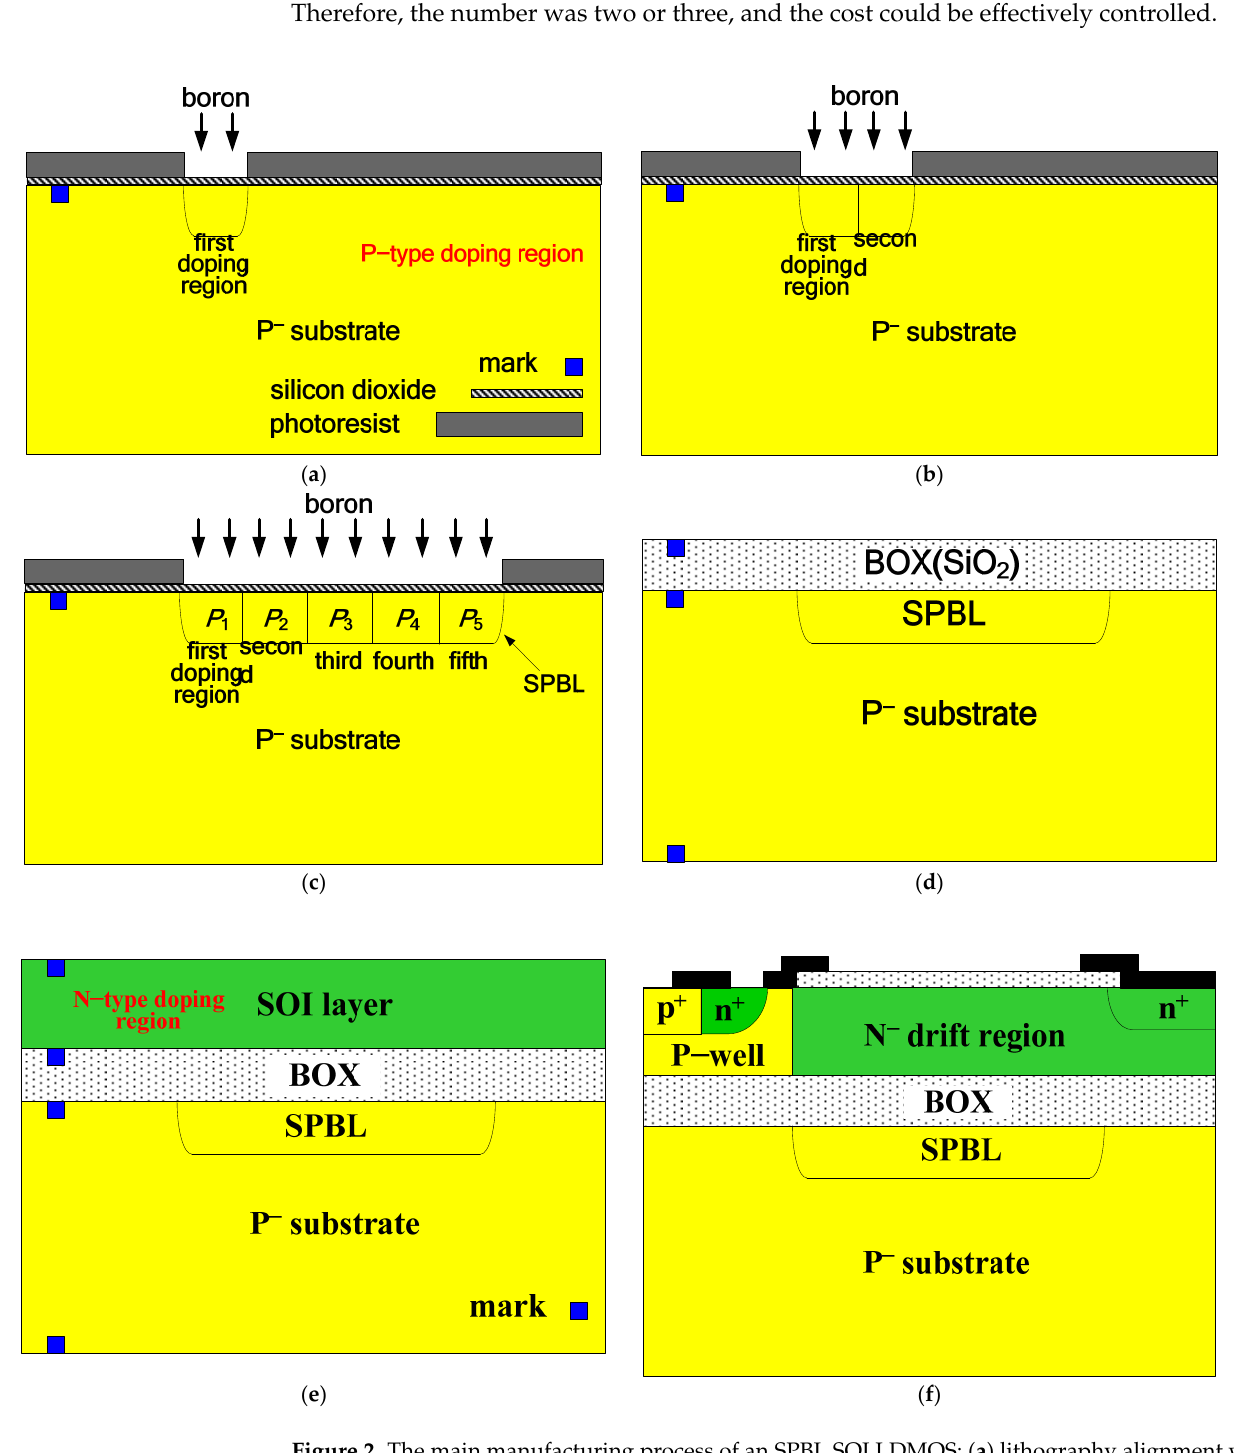
Figure 2. The main manufacturing process of an SPBL SOI LDMOS: ( a ) lithography alignment with marks, boron − ion implantation from the window to form the first doping region; ( b ) double the width of the window to the right, another boron − ion implantation to form the second doping region; ( c ) after five consecutive ion implantations, the formation of a SPBL; ( d ) deposition and planarization of SiO 2 and creation of alignment marks for double − sided lithography; and ( e ) bonding of SiO 2 and Si, thinning of the SOI layer and lithography alignment with marks. ( f ) The other manufacturing steps for the device are compatible with the standard manufacturing process for an SOI